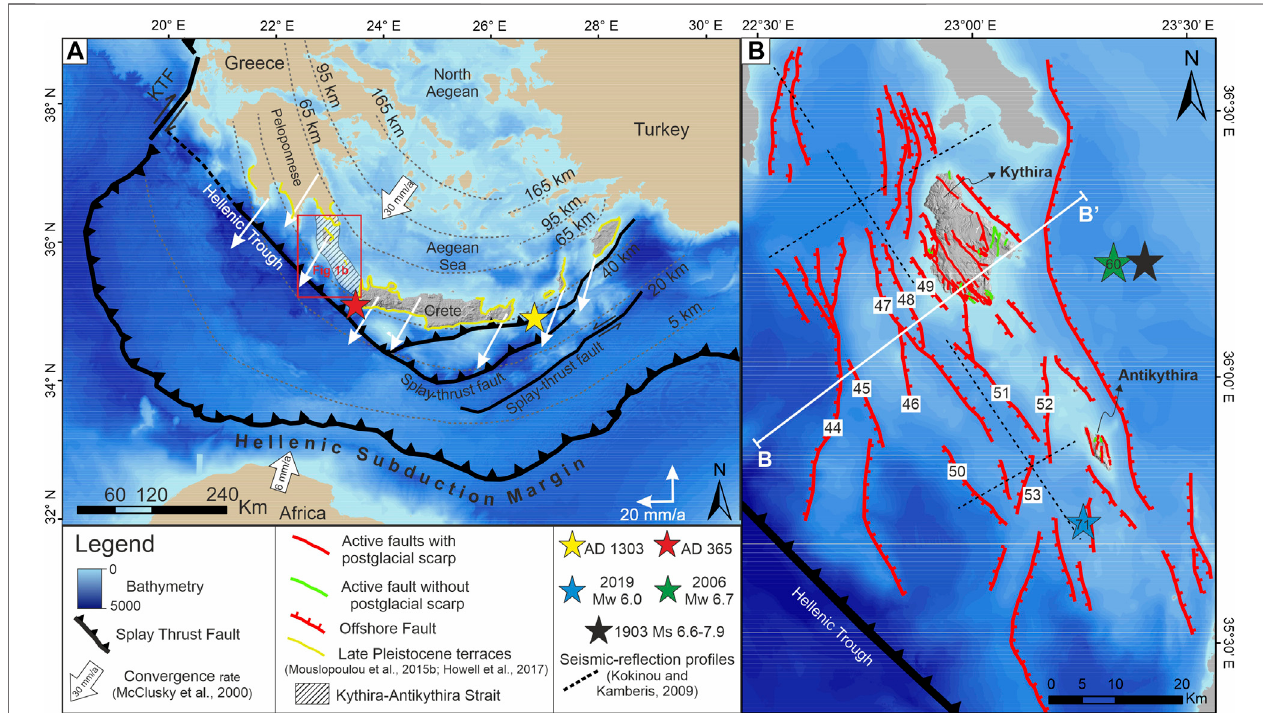
FIGURE 1 | (A) Map illustrating the main morphotectonic elements of the Hellenic Subduction System (HSS). The study area is indicated by red polygon. Black- dashed lines are isodepths to the top of the plate-interface (from Bocchini et al., 2018). Late Pleistocene marine terraces are indicated by yellow lines (Mouslopoulou et al.,2015b;Howelletal.,2017).Redandyellowstarsindicatetheepicentres oftheAD365(M8.3)andAD1303(M8)earthquakes, respectively.GPSvelocities relative to the Eurasian plate are shown by white arrows (McClusky et al., 2000). The splay-thrust faults that de fi ne the Hellenic Trough are indicated (modi fi ed from Mouslopoulou et al., 2015a). KTF is Kefalonia Transform Fault. (B) Fault map of the Kythira and Antikythira Strait (KAS). The 2006 Mw 6.7 and the 2019 Mw 6.1 earthquakes are shown by green and blue stars, respectively. Numbers within the stars indicate hypocentre depth. Numbers in white squares correspond to fault IDs presented in Supplementary Table S1 . The location of the pro fi le B-B ′ used to calculate extension rate across the KAS, is indicated.